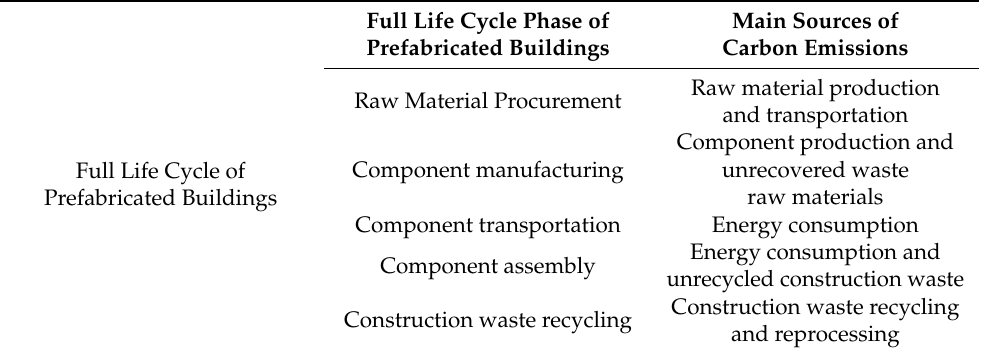
Figure 2. Carbon flow analysis of the supply chain of prefabricated building. Table 1. Full life cycle carbon emission